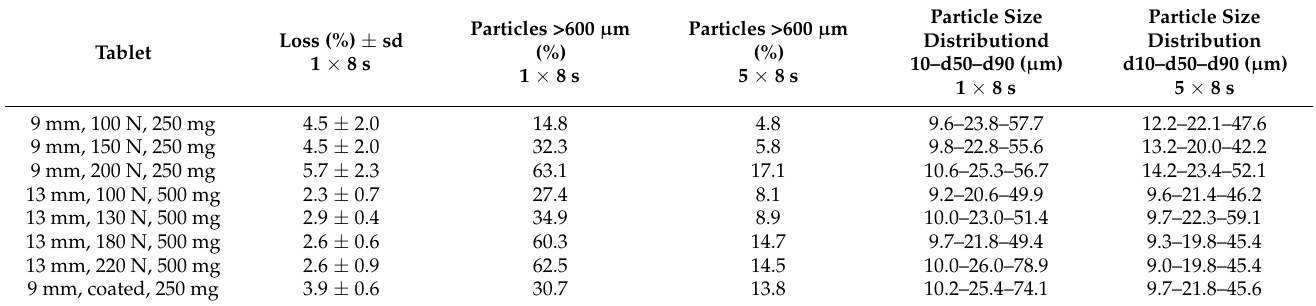
Table 5. Performance of electric grinder Severo. Percentage loss (mean ± sd, n = 6), particle size fraction >600 µ m, and particle size distribution of the fraction <600 µ m. Grinding time of 1 × 8 s and 5 × 8 s are compared. Six tablets were ground one by one, and the obtained powders were pooled for analysis.